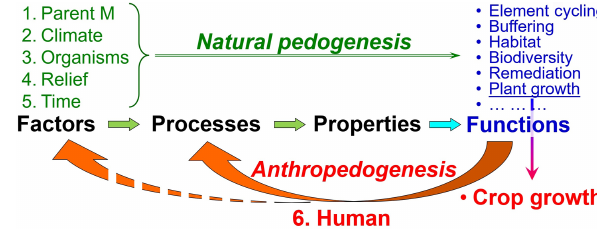
Figure 2. Soil genesis based on the five natural factors of soil for- mation and the sixth factor: human. Natural processes are presented in green, and human processes are presented in red. The concept factors → properties was suggested by Dokuchaev (1883) and Za- kharov (1927; see Supplement) and later by Jenny (1941). The the- ory we introduced, factors → processes → properties → functions, considers not only the functions of natural soils but also human modification of soils toward only one function of interest (here crop growth). Anthropogenic optimization of only one function involves strongly modifying processes and factors, leading to formation of a new process group: anthropedogenesis. The arrows pointing down- ward reflect the main specifics of anthropogenesis: one of the func- tions becomes a factor of pedogenesis and modifies the